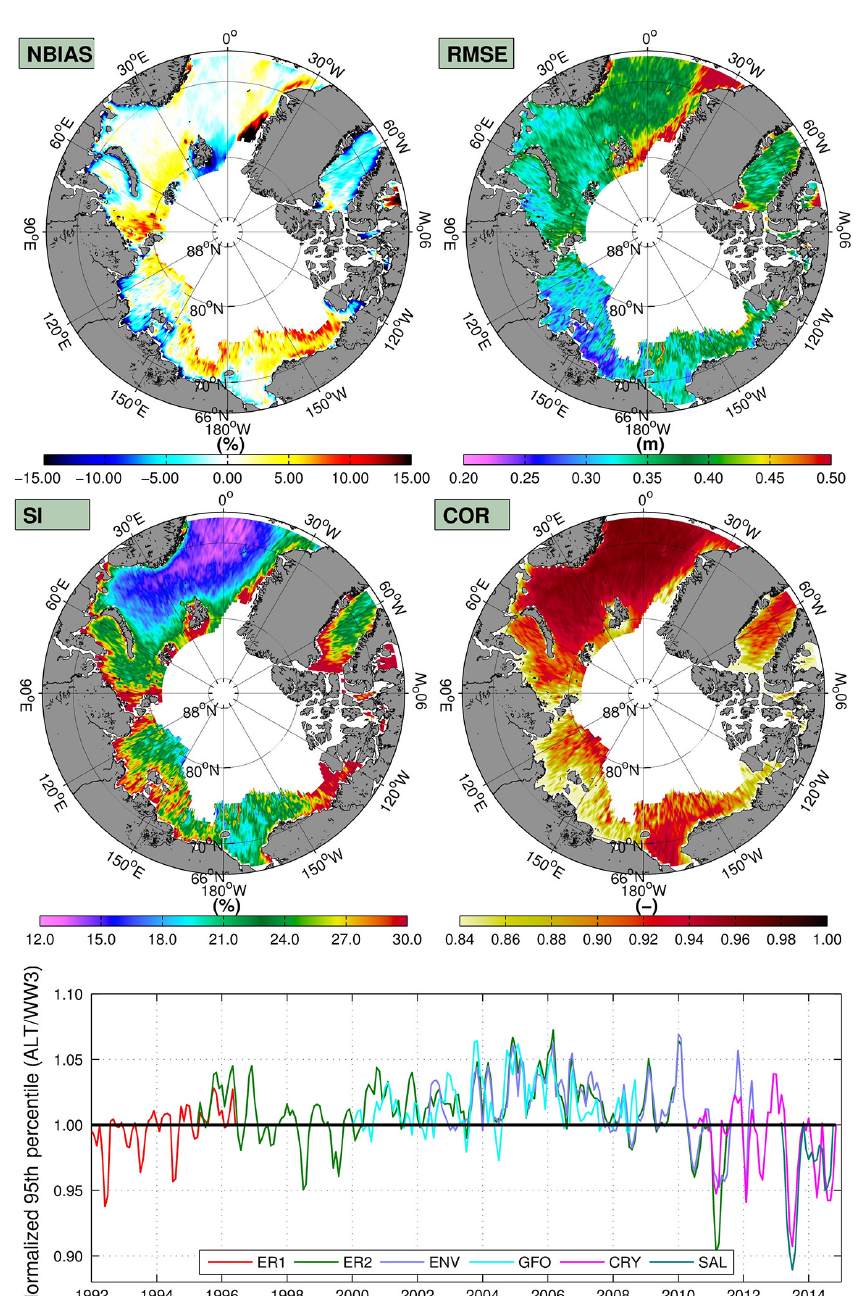
Figure 3. Top four panels display the normalized bias (NBIAS), root-mean-square error (RMSE), scatter index (SI), and correlation coeffi- cient (COR) for collocated H s for the CFSR wave hindcast and the merged altimeters 1992–2014. The bottom panel displays the normalized monthly H s 95th percentile for each satellite platform: European Remote Sensing satellites 1 and 2 (ER1, ER2), Environmental Satellite ENVISAT (ENV), Geosat Follow-On (GFO), CRYOSAT2 (CRY), and Altika SARAL